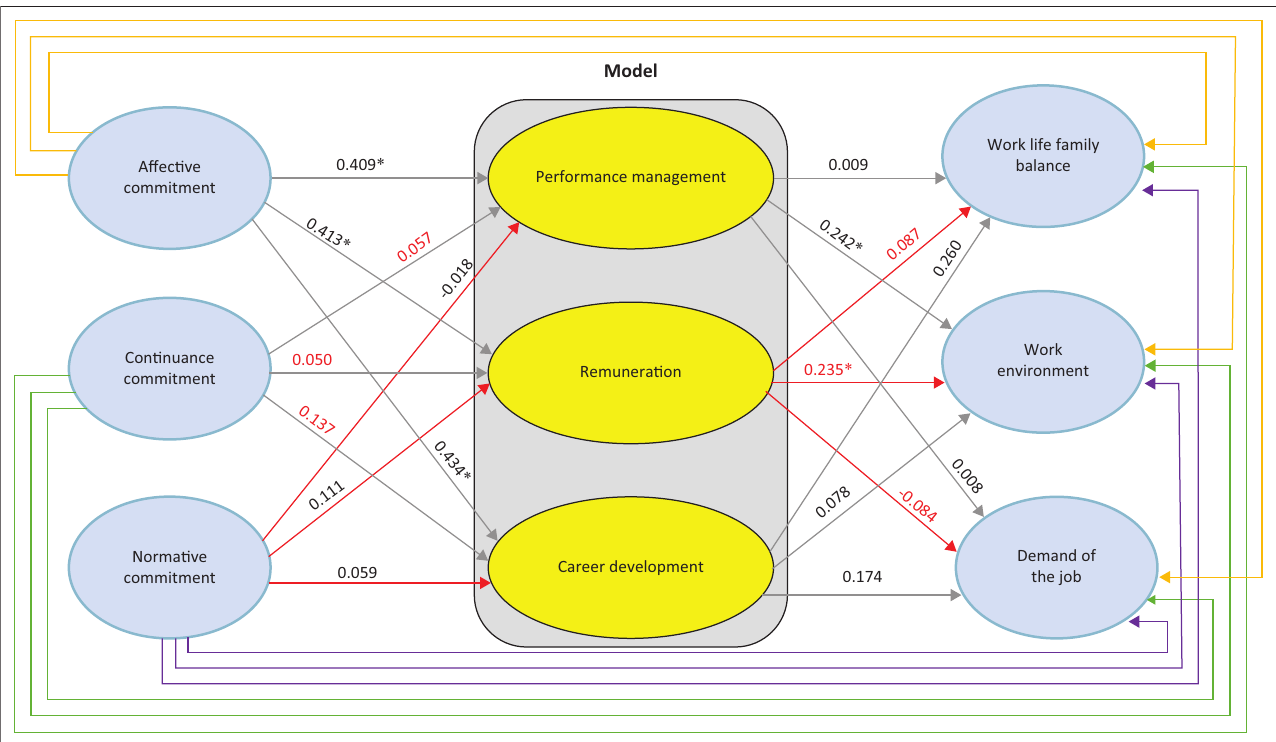
FIGURE 1: A framework for talent management, organisational commitment and employee turnover intention at a government department in South Africa.